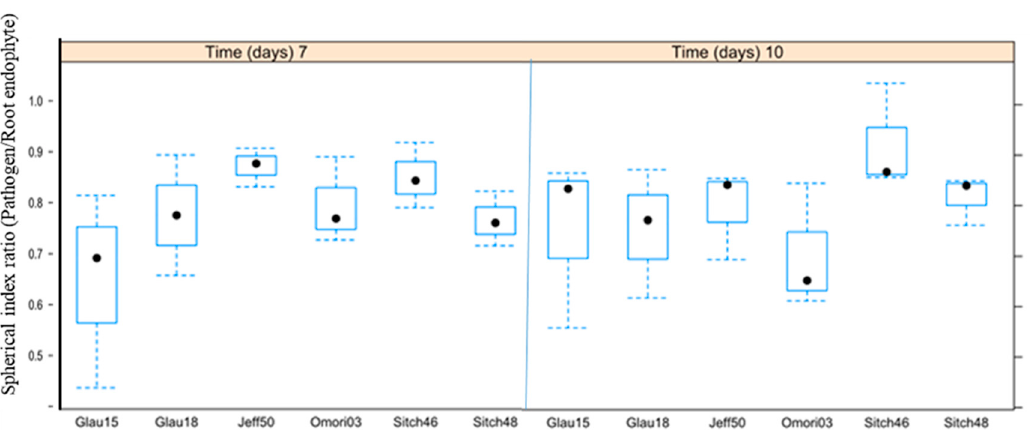
Figure 5. Ratios of the mean spherical indices of the pathogen over its antagonistic partner from day 7 and day 10 measurements of the antagonism assay visualized side-by-side in box-and-whisker plots (solid black circles—medians). Samples shown here are only those which displayed statistically significant antagonism on both days of measurement.